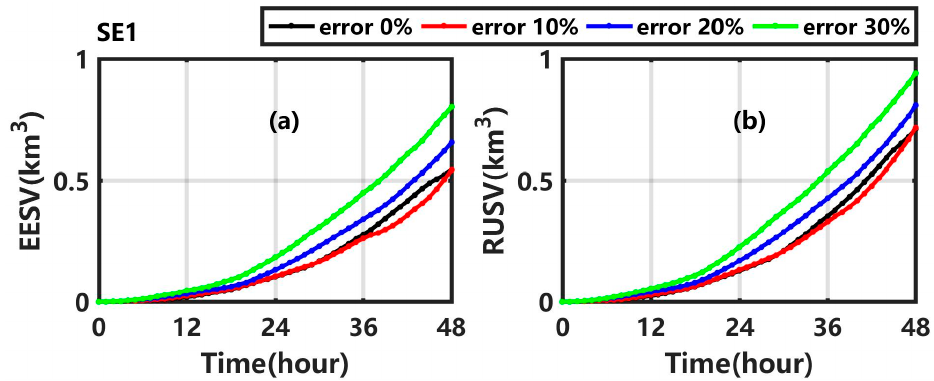
Figure 6. ( a ) EESV and ( b ) RUSV in Exp1 (black line), SE1_1 (red line), SE1_2 (blue line), and SE1_3 (green line).